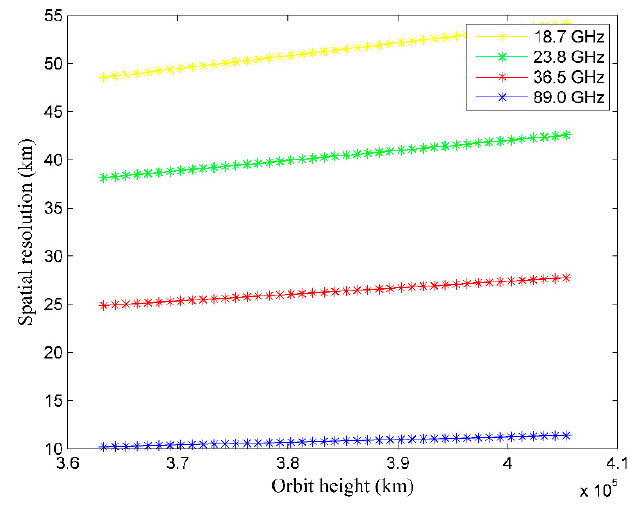
Figure 7. The change of spatial resolution with orbit height.